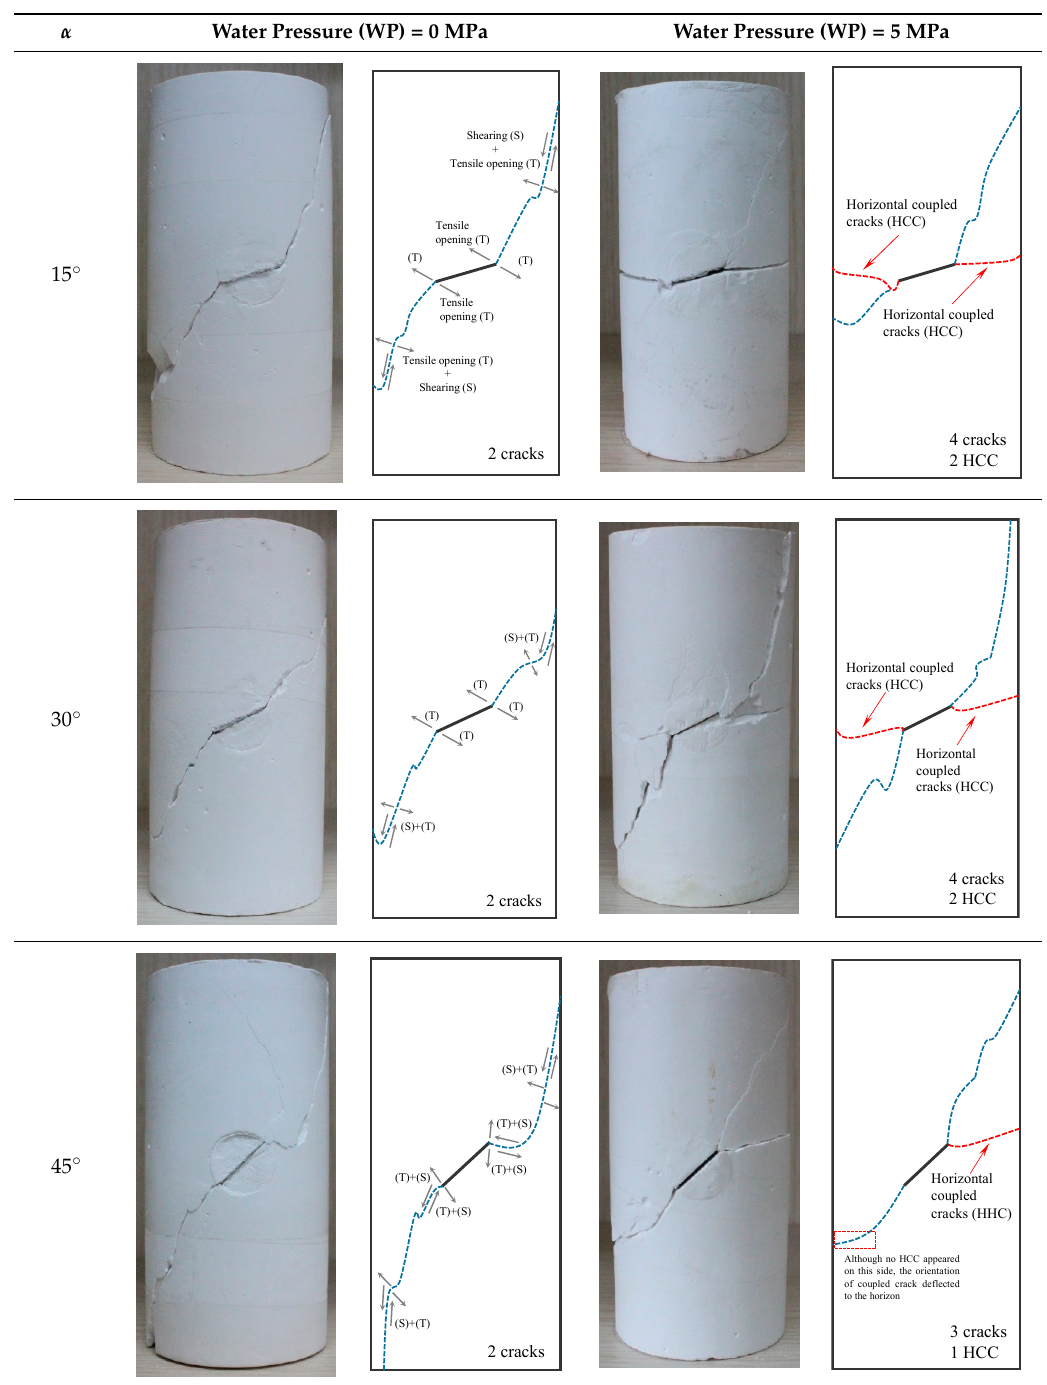
Table 2. Fracturing trajectories of dry cracks and coupled cracks.